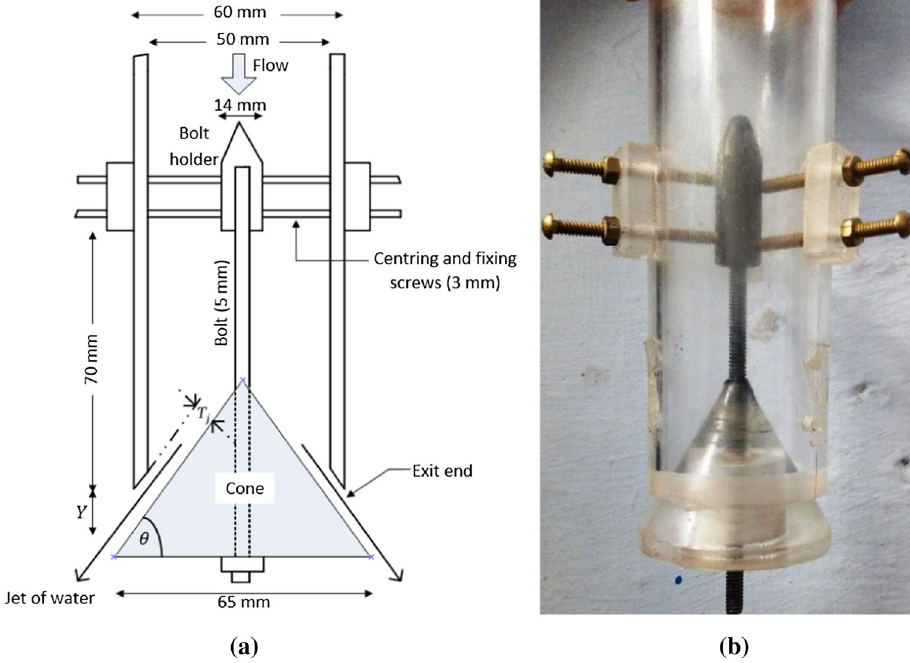
Fig. 1 Hollow jet aeration